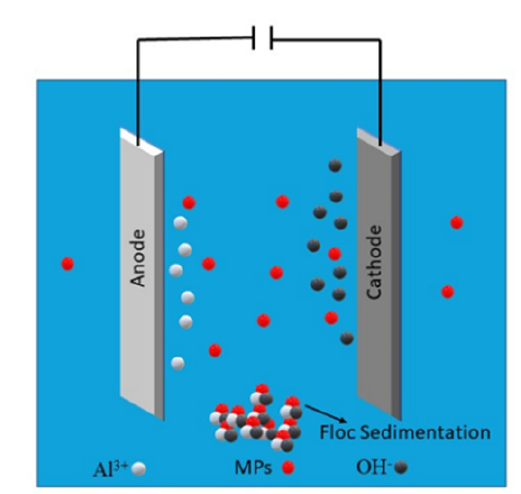
Figure 8. Setup of Figure 8. Setup of electrocoagulation. Table 3. Outcome of different experiments for separation of microplastics using electrocoagulation.